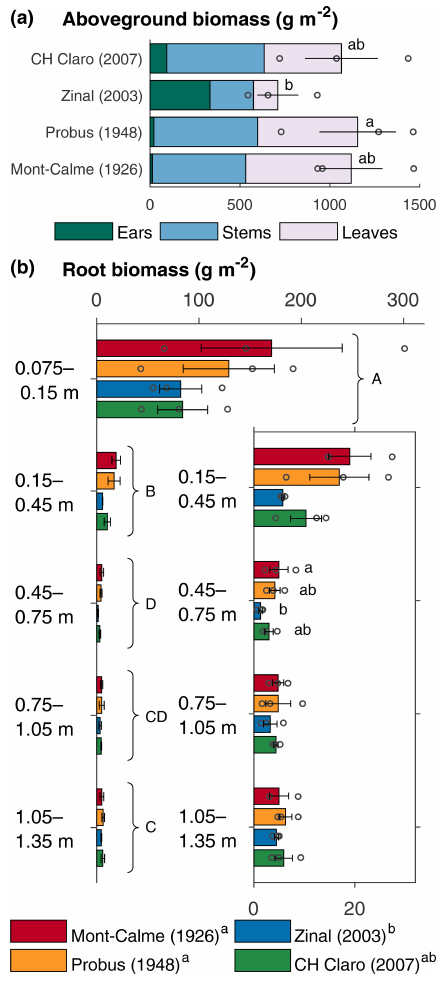
Figure 1. Aboveground (a) and root (b) biomass of the different wheat cultivars at the end of the experiment. Bars represent the av- erage per wheat cultivar, error bars show the standard error ( n = 3) and circles show the individual data points. The inset in (b) shows a detail of the subsoil root biomass. If statistically significant differ- ences were present, these are indicated with letters, with variables sharing a letter not being significantly